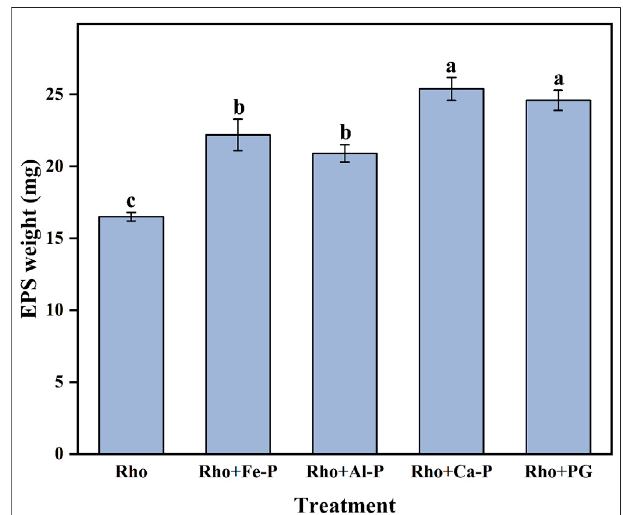
FIGURE 3 | Removal ratio of Pb in each treatment after 6 days of incubation. The error bars represent the standard deviations of three replicates.Thesigni fi cantdifferencesamongthetreatmentswereidenti fi edby Tukey ’ s honestly signi fi cant difference test ( p < 0.05) via one-way ANOVA.